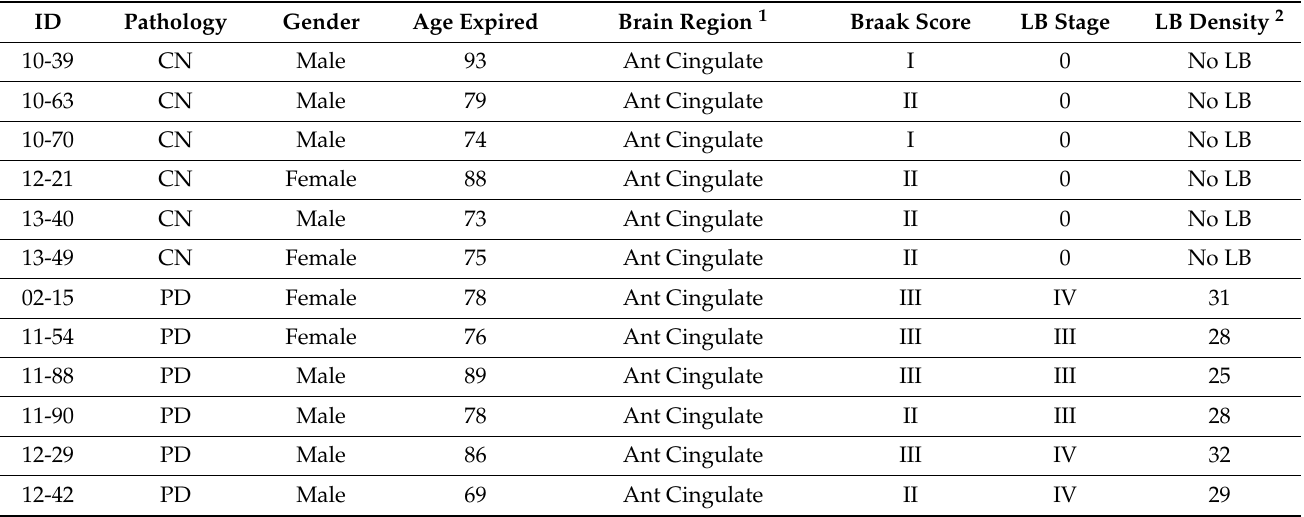
Table 1. Patient samples and data